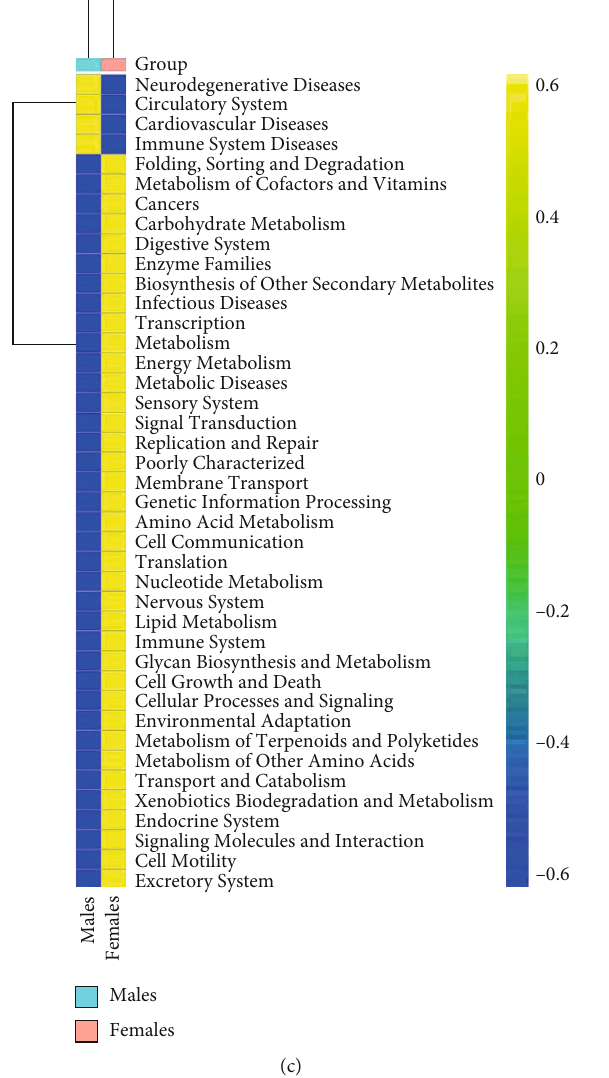
Figure 6: KEGG pathway enrichment analysis. (a) The di ff erent pathways in individual patients are shown in clustering heat maps at level 2 and (b) level 3 of KEGG. (c) At level 2 of KEGG, the di ff erent pathways between the two groups were clustered into a heat